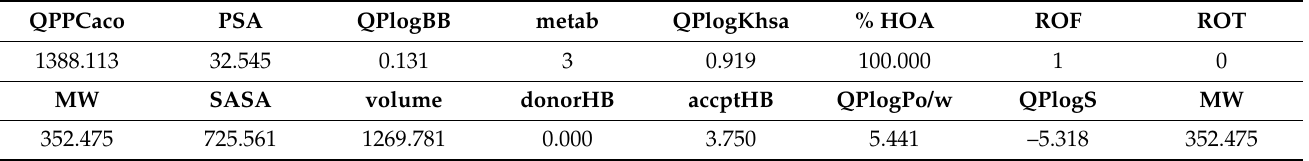
Table 3. Qikprop calculated physicochemical properties for nitrone 5